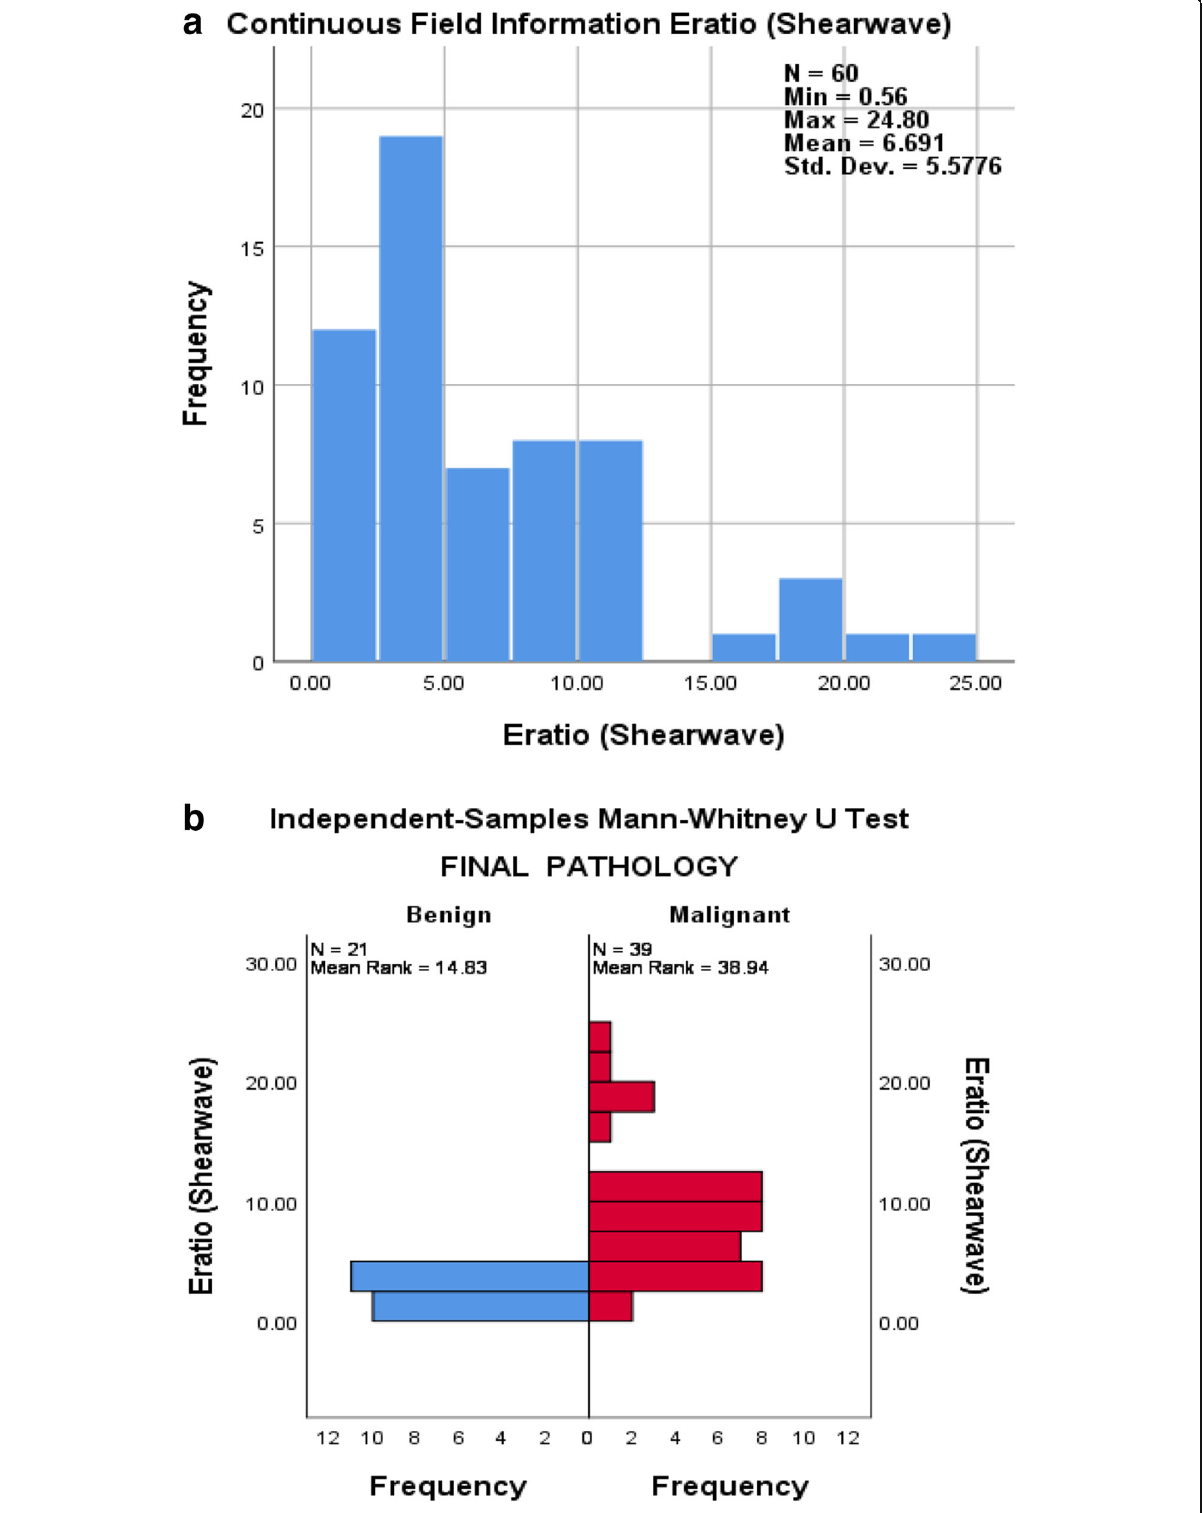
Fig. 2 a Distribution of Eratio values for the examined nodes. b Distribution of Eratio values for benign and malignant